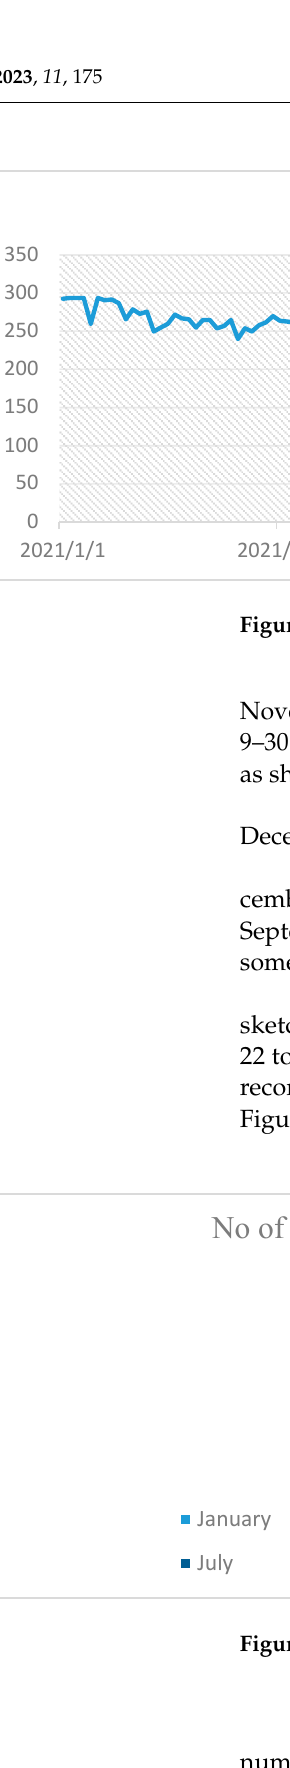
Figure 11. Number of system shutdowns in 2019.